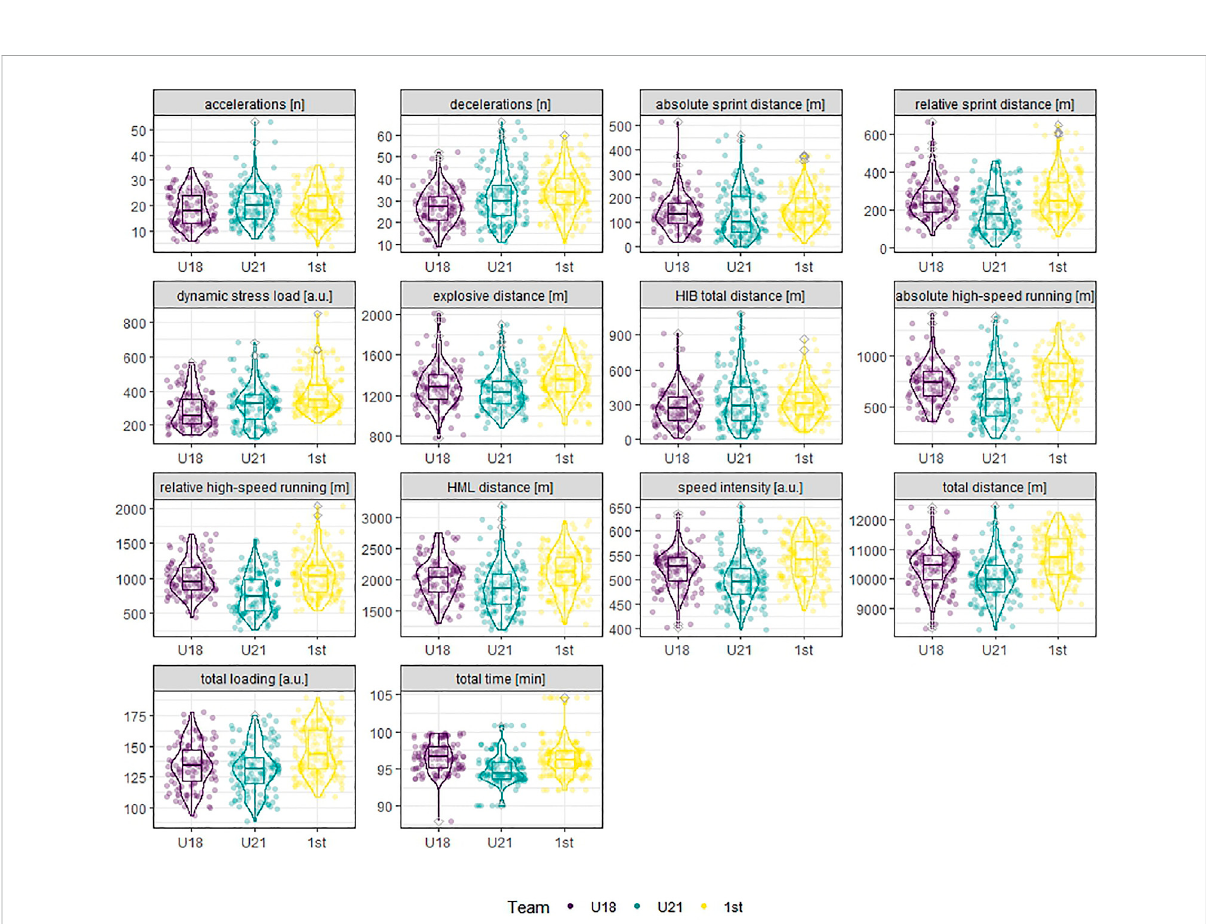
FIGURE 1 Distribution, median, fi rst and third quartiles (the 25th and 75th percentiles) of each of the external load measures visualized per team. Outliers (values further than 1.5 * inter-quartile range from the hinge) are indicated by grey opened diamonds. a.u. = arbitrary units.